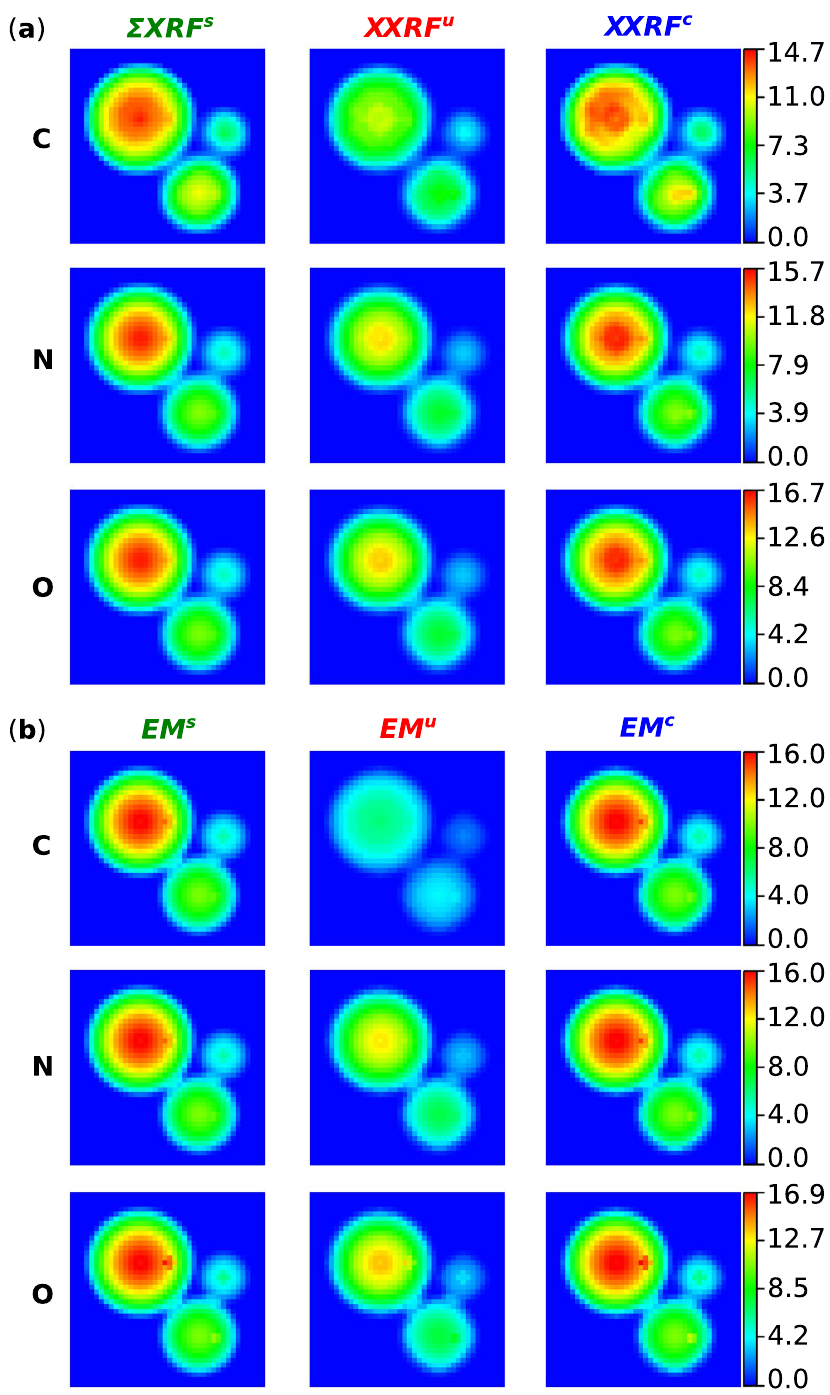
Figure 6. Sum of the count rates in logarithmic scale, across all the SDDs of the (cid:31) XRF maps ( a ) and of the EM ij matrices ( b ), for elements C, N and O included in the simulation, specifically for the line K simulated, absorption uncorrected and absorption corrected data